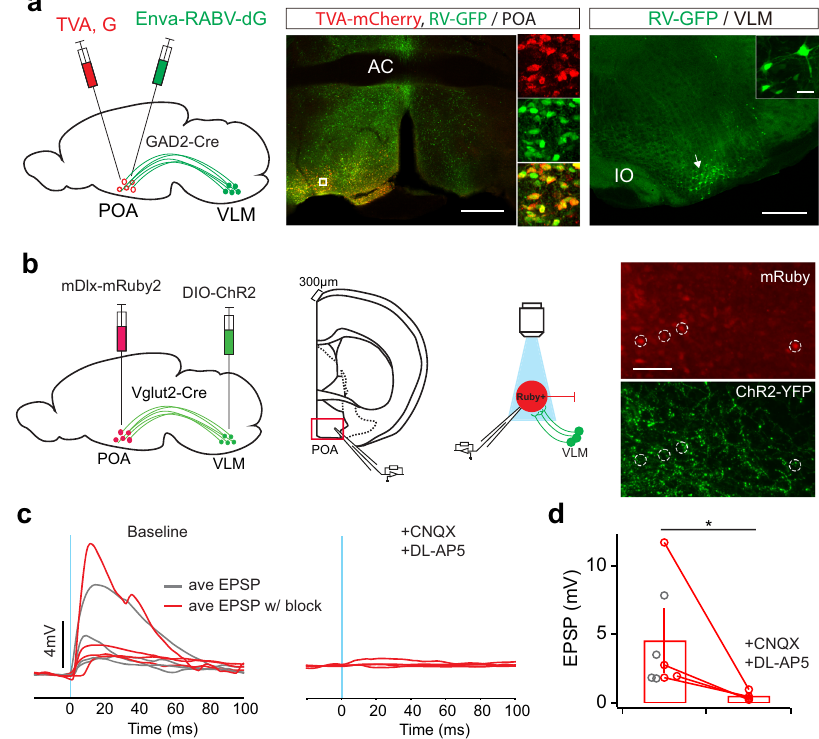
Fig. 4 | VLM glutamatergic neurons activate GABAergic neurons in the POA. a Monosynaptic retrograde tracing from the POA to VLM in GAD2-Cre mice. Left, schematic of experimental design. The POA of GAD2-Cre animals were infected with AAV-FLEX-G(N2C)-mKate and AAV-FLEX-TVA-mCherry, followed by infection with RABV- Δ G-GFP-EnvA. Middle, fl uorescence image of the injection site in the POA. Scale bar, 500 μ m. Enlarged view of the region in the white box showing starter cells labeled by mCherry (red), Rabies-labeled cells labeled by GFP (green). Right, Rabies-labeled cells in the VLM indicated by GFP expression (green). Representativeof2mice.Scalebar,500 μ m.Arrowindicatescellsininset.Scalebar, 20 μ m. b Schematic of experimental design. AAV-DIO-ChR2-eYFP was injected unilaterally in the VLM, AAV-mDlx-mRuby2 injected contralaterally in the POA of Vglut2-Cremice.RecordingswereperformedinmRuby+cellsinthePOAwhilelight